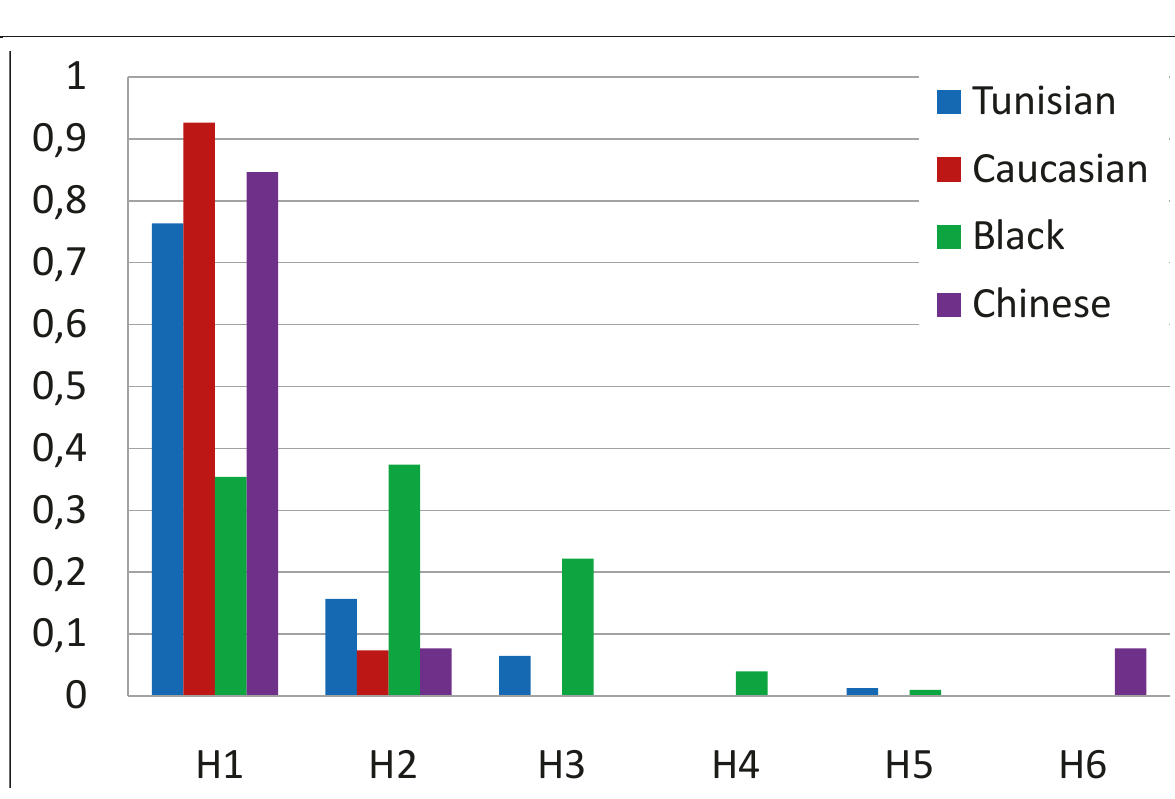
Figure 2 Comparison of haplotype frequencies between Tunisian hemophiliac and others ethnic groups